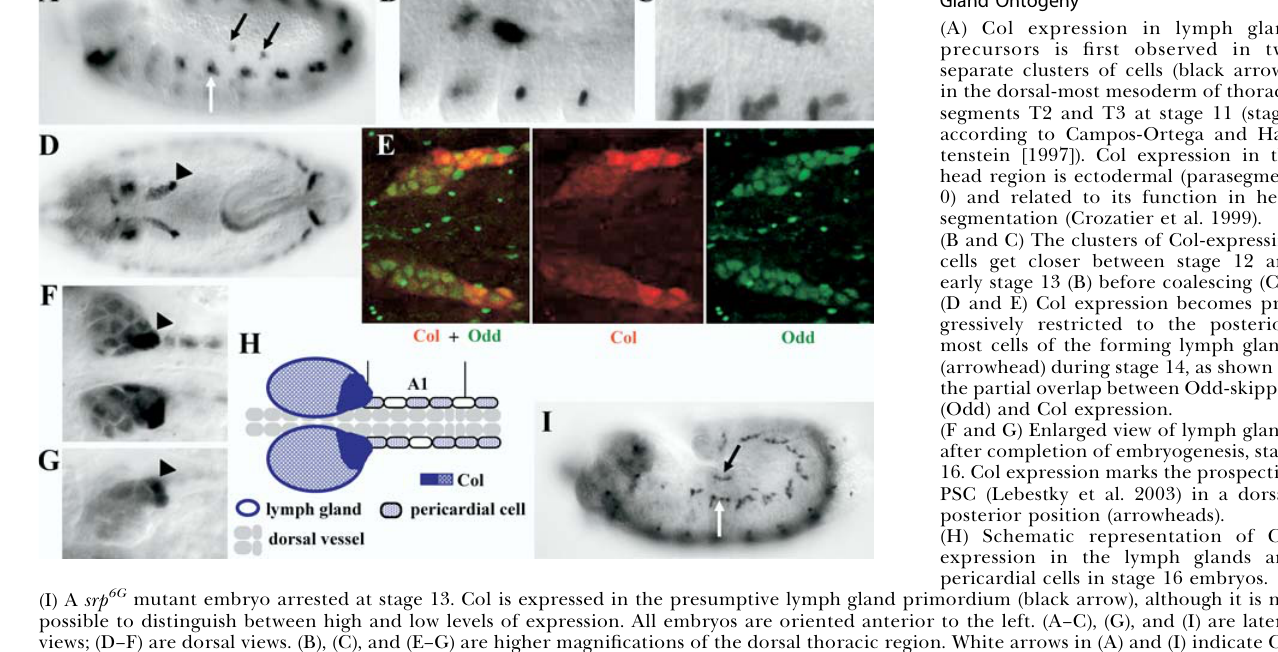
Figure 1. Col Expression during Lymph Gland Ontogeny (A) Col expression in lymph gland precursors is first observed in two separate clusters of cells (black arrows) in the dorsal-most mesoderm of thoracic segments T2 and T3 at stage 11 (stages according to Campos-Ortega and Har- tenstein [1997]). Col expression in the head region is ectodermal (parasegment 0) and related to its function in head segmentation (Crozatier et al. 1999). (B and C) The clusters of Col-expressing cells get closer between stage 12 and early stage 13 (B) before coalescing (C). (D and E) Col expression becomes pro- gressively restricted to the posterior- most cells of the forming lymph glands (arrowhead) during stage 14, as shown by the partial overlap between Odd-skipped (Odd) and Col expression. (F and G) Enlarged view of lymph glands after completion of embryogenesis, stage 16. Col expression marks the prospective PSC (Lebestky et al. 2003) in a dorsal- posterior position (arrowheads). (H) Schematic representation of Col expression in the lymph glands and